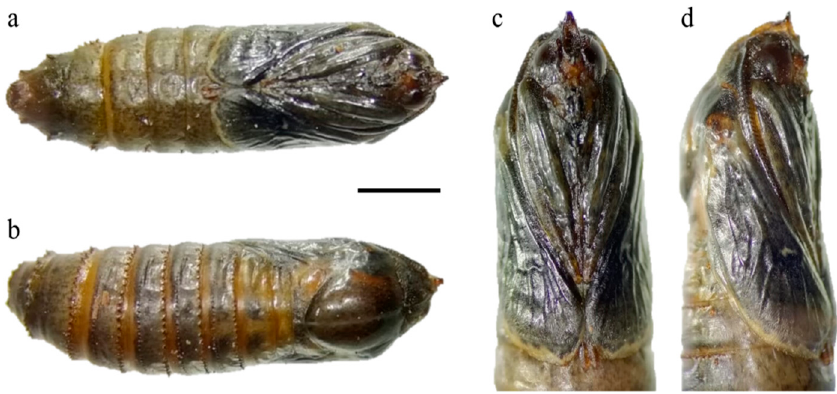
Figure 4. Pupa of Givira ethela . ( a , c ) Frontal view, at different magnifications; ( b ) Back side; ( d ) Right side. Scale bar: ( a , b ) = 2.0 mm; ( c , d ) = 1.5 mm.